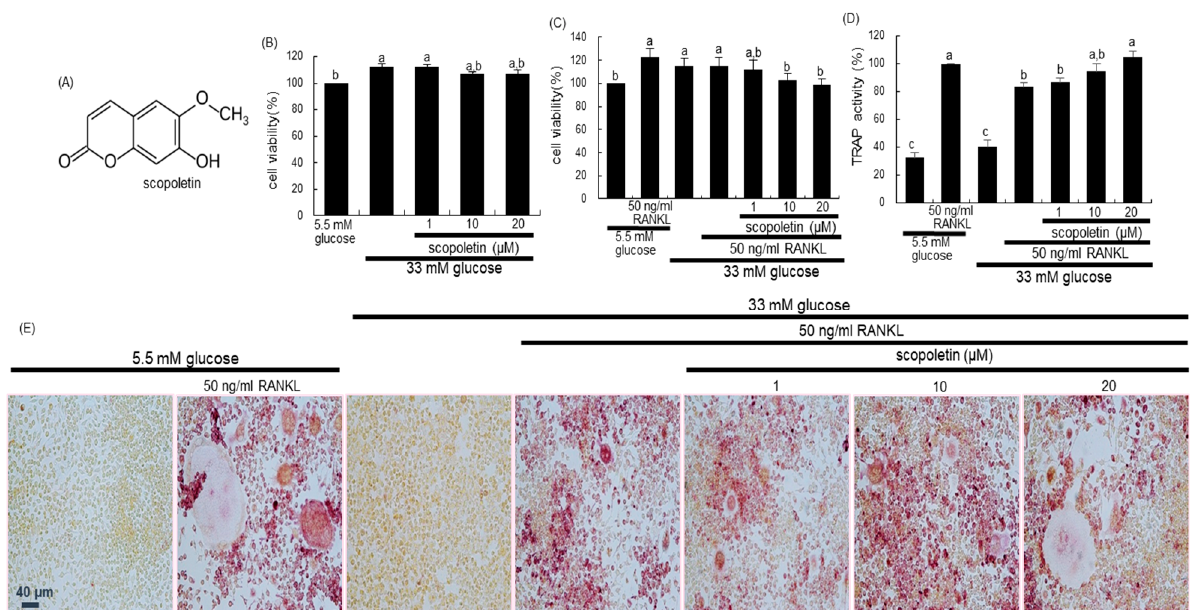
Figure 1. The chemical structure of scopoletin ( A ), and toxicity of pre-osteoclastic Raw 264.7 cells by glucose and scopoletin ( B , C ), tartrate-resistant acid phosphatase (TARP) activity ( D ), and TRAP staining ( E ). Raw 264.7 cells were cultured in α -MEM media containing 33 mM glucose for 2 days in the absence and presence of 1–20 μ M scopoletin and/or 50 ng/mL receptor activator of nuclear factor- κ B-ligand (RANKL). Cell viability was measured by MTT assay and expressed as percent cell survival relative to 5.5 mM glucose controls (cell viability =100%, mean ± SEM, n = 7). After Raw 264.7 cells were cultured for five days, the TRAP activity was measured using a kit ( D ). TRAP-positive multinucleated osteoclasts were stained and visualized under light microscopy ( E ). Scale bar = 40 μ m. Values in bar graphs (mean ± SEM, n = 4) not sharing a common small letter indicate significant difference at p < 0.05.